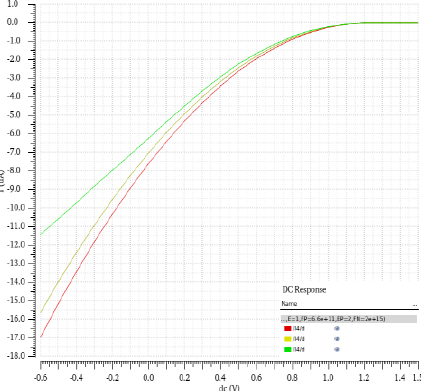
Fig. 5. Dependence I D (V D ) when combined with the fluxes of neutrons, electrons and